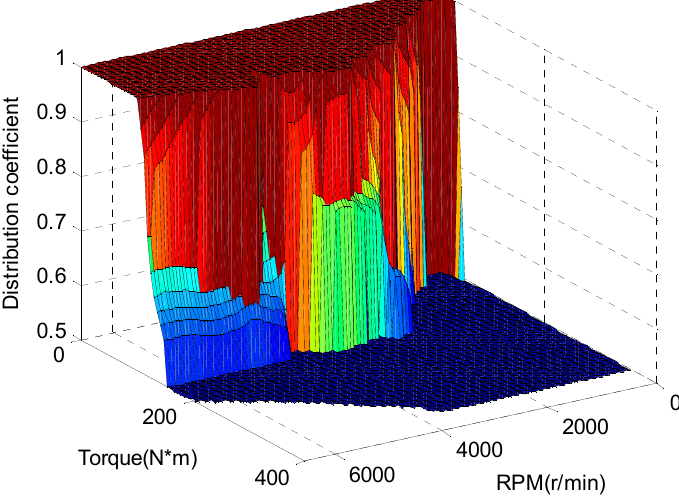
Figure 4. Economy distribution coefficient map.